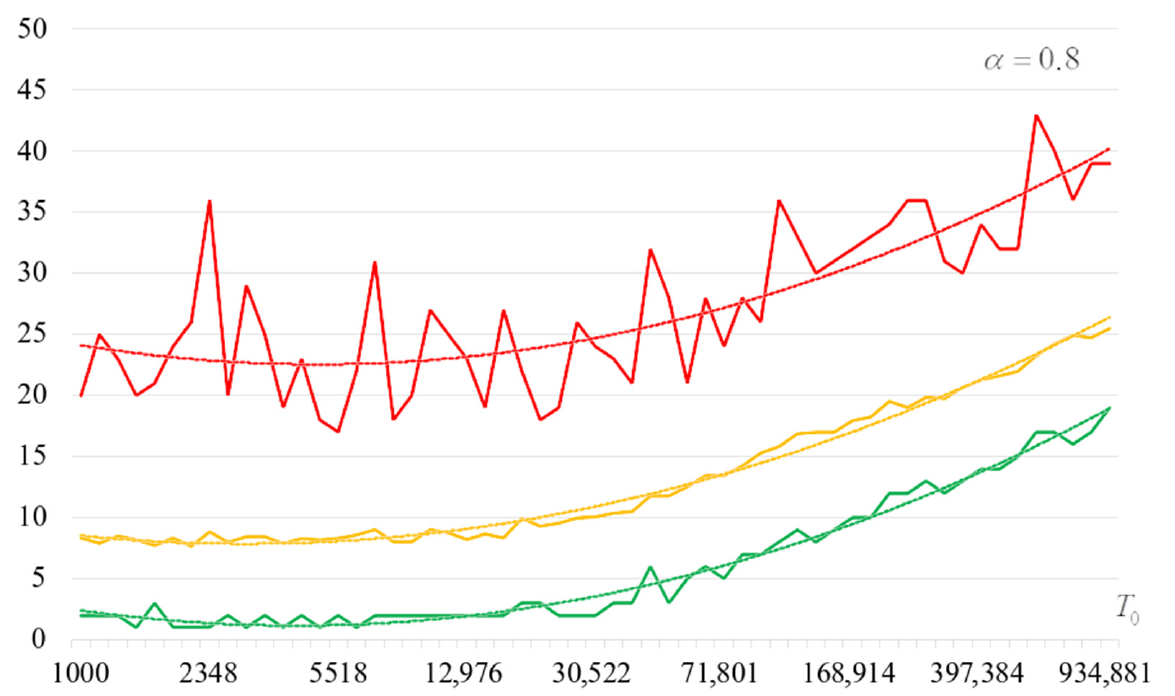
Figure 12. The dependence of the number of iterations of an external loop (until one of the criteria for stopping the algorithm is met), 𝛼 = 0.8 .